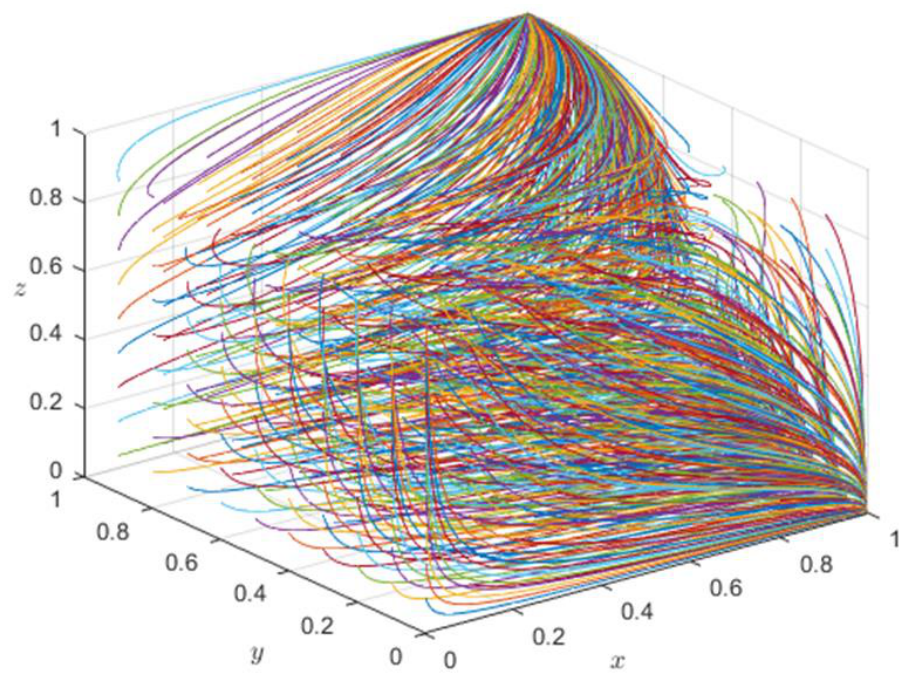
Figure 3. System evolution with different initial strategy ratios.